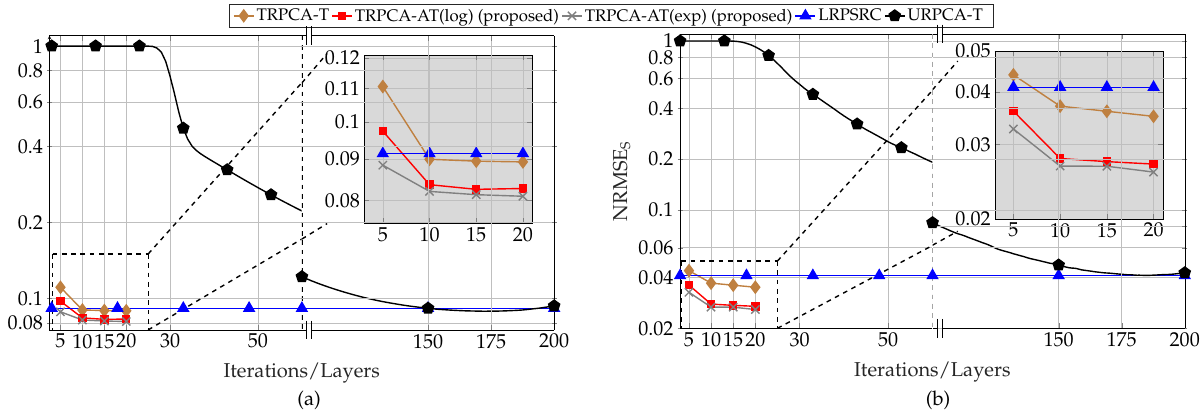
Figure 3. Average recovery error of low-rank ( a ) and sparsity ( b ) contributions for compression ratio K / MN = 50% for ADMM-based trained RPCA with thresholding (TRPCA-T), proposed ADMM- based trained RPCA with adaptive thresholding based on logarithm heuristic (TRPCA-AT(log)), proposed ADMM-based trained RPCA with adaptive thresholding based on exponential heuristic (TRPCA-AT(exp)), low-rank plus sparse recovery with convex relaxation (LRPSRC), and ADMM- based untrained RPCA with thresholding